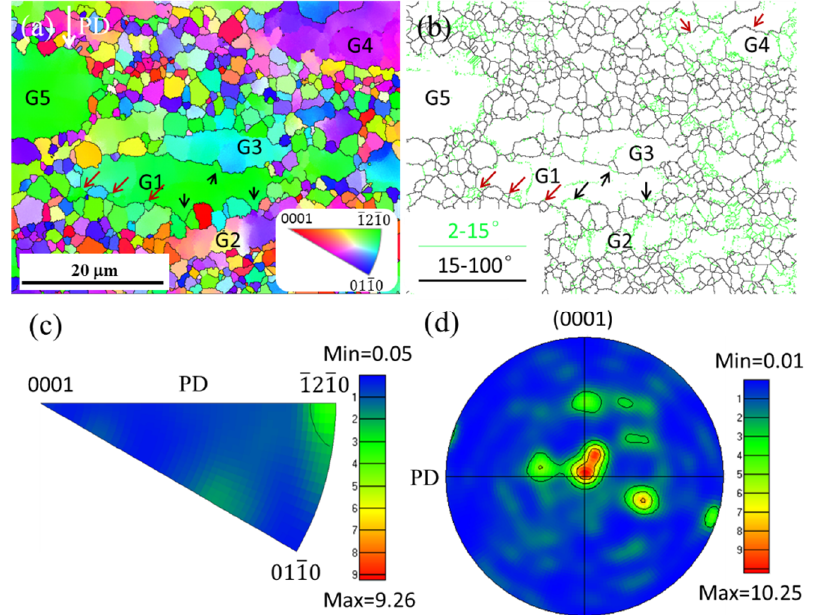
Figure 11. Inverse pole figure (IPF) map ( a ) of the compressed AC WE43 alloy after true strain of 1.2 with strain rate of 0.05 s − 1 along with its corresponding ( b ) boundary map, ( c ) typical IPF and ( d ) (0001) basal pole figure (PF). The compression direction (PD) is shown in picture ( a ) (the same below).